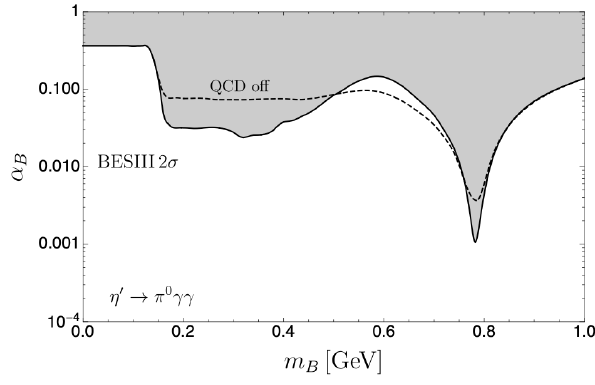
Figure 2. Limits on the leptophobic B -boson coupling α B for di ff erent m B masses from the BR mea- surements of the decay η (cid:48) → π 0 γγ [11] by BESIII. The grey shaded region is excluded and the dashed black line corresponds to the limit with the QCD contributions set to